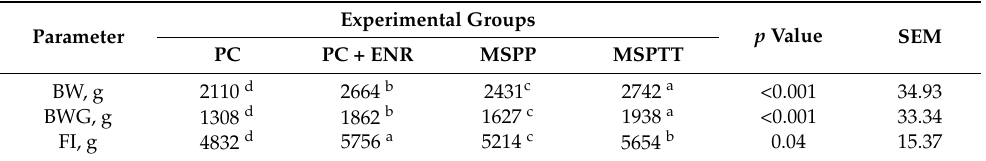
Table 4. Effect of multi-strain probiotics and enrofloxacin supplementation on growth performance attributes of experimentally-infected rabbits at the end of finishing period (90